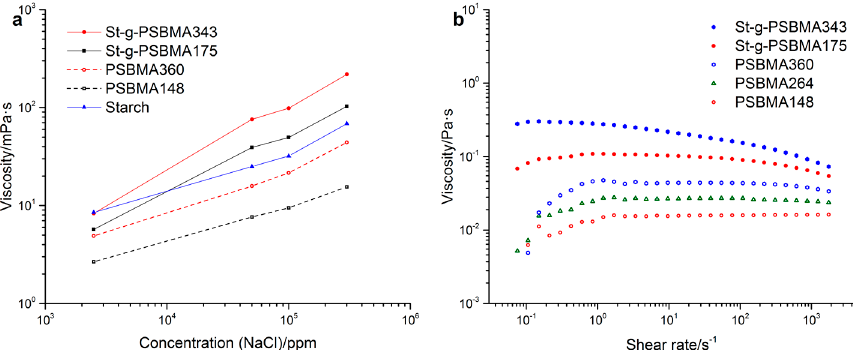
Figure 5 . Solution viscosity vs. salt concentration (( a ) shear rate 9.6 s − 1 ) and solution viscosity vs. shear rate ( b ).